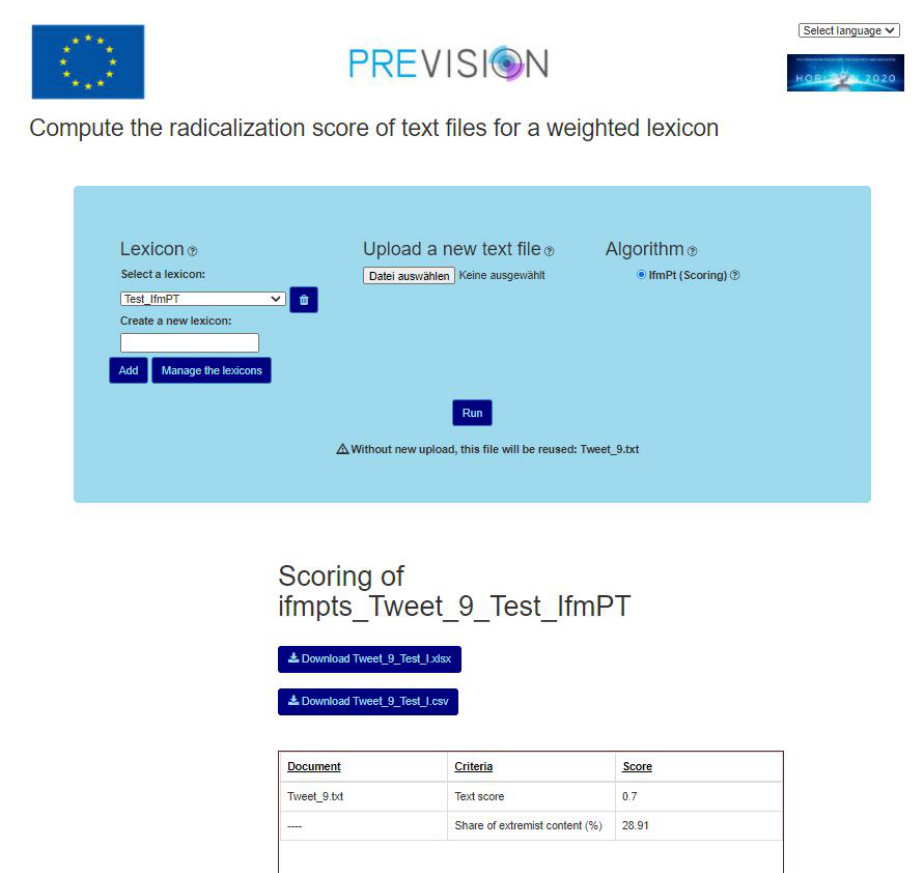
Figure 6. This figure shows the API of the application that calculates the radicalisation score of text files for a weighted lexicon. First, the user selects the lexicon to be used and the file or directory to analyse (top part of the figure). As a result, the overall score of the texts is